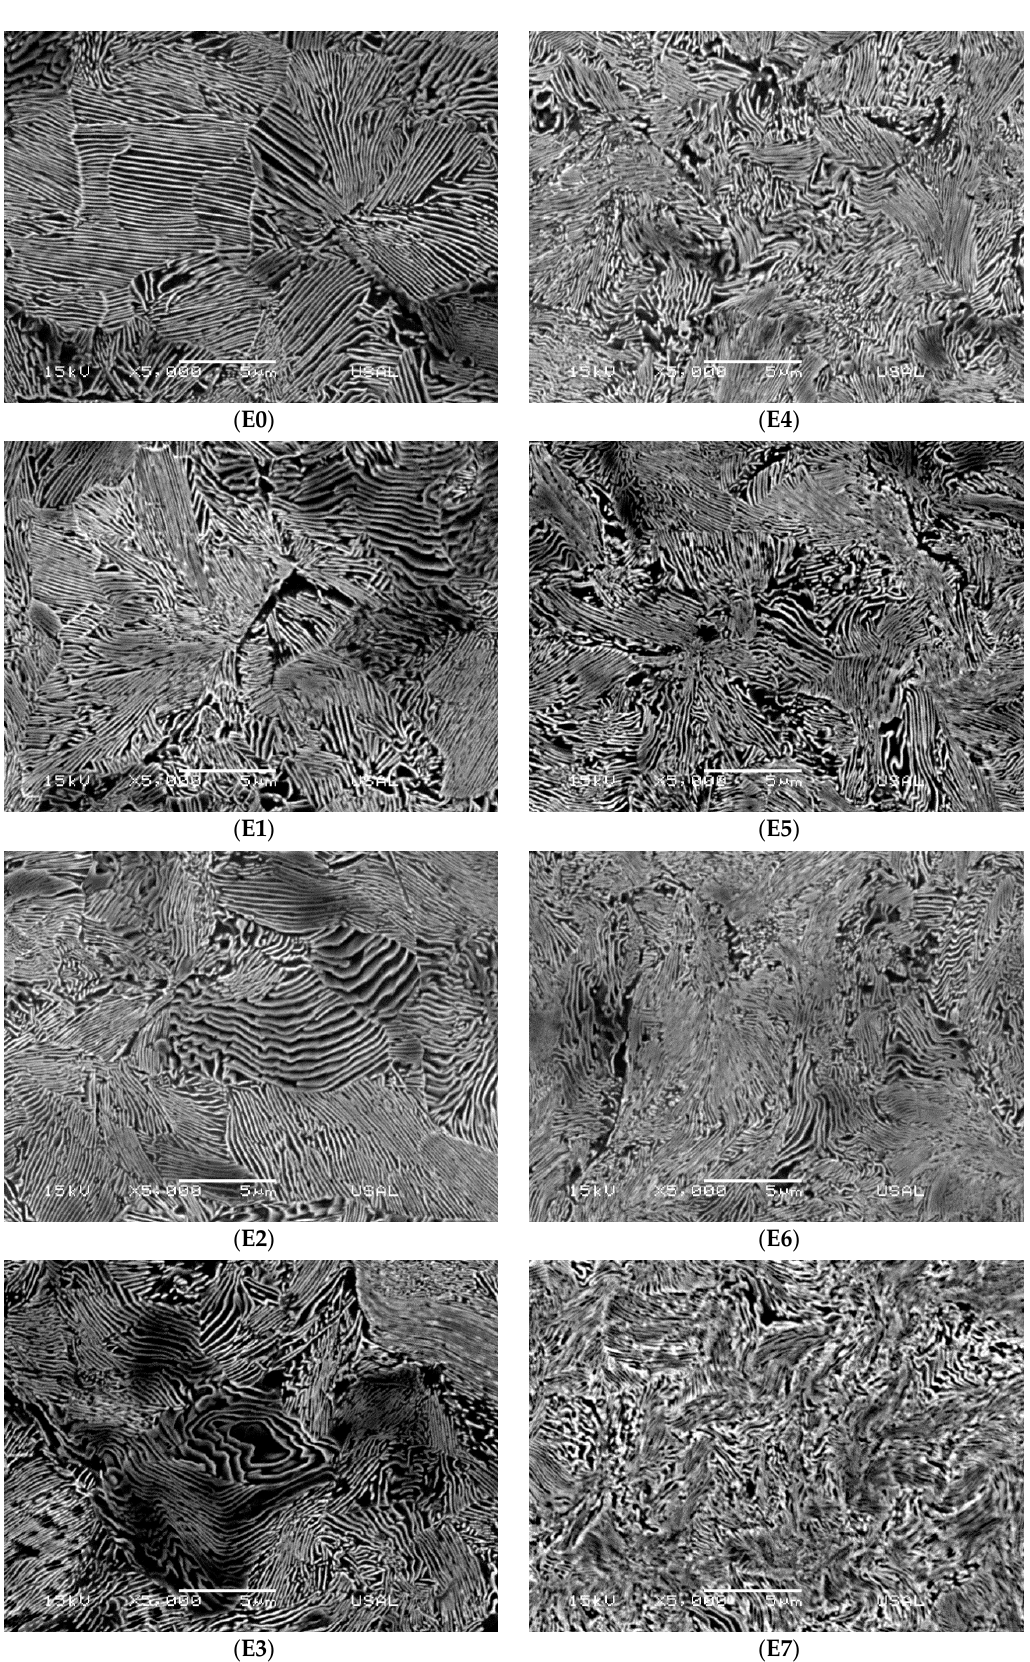
Figure 5. Metallographic analysis of the transverse section of family E for diverse drawing steps.